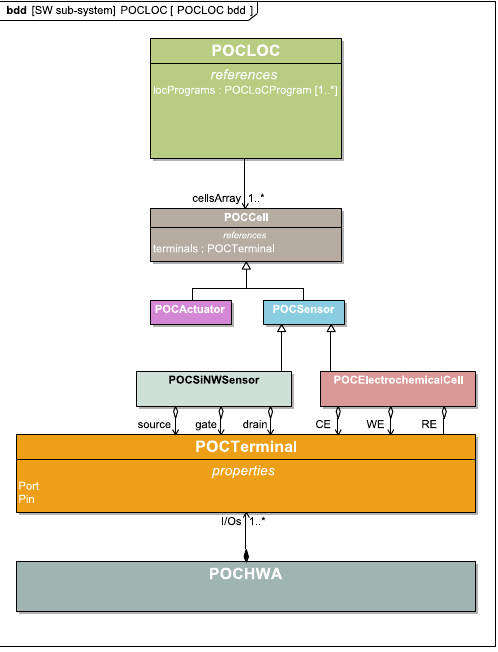
Figure 5. iOS software classes for the main LoC architectural components and their relation to the HWA/LoC interfacing